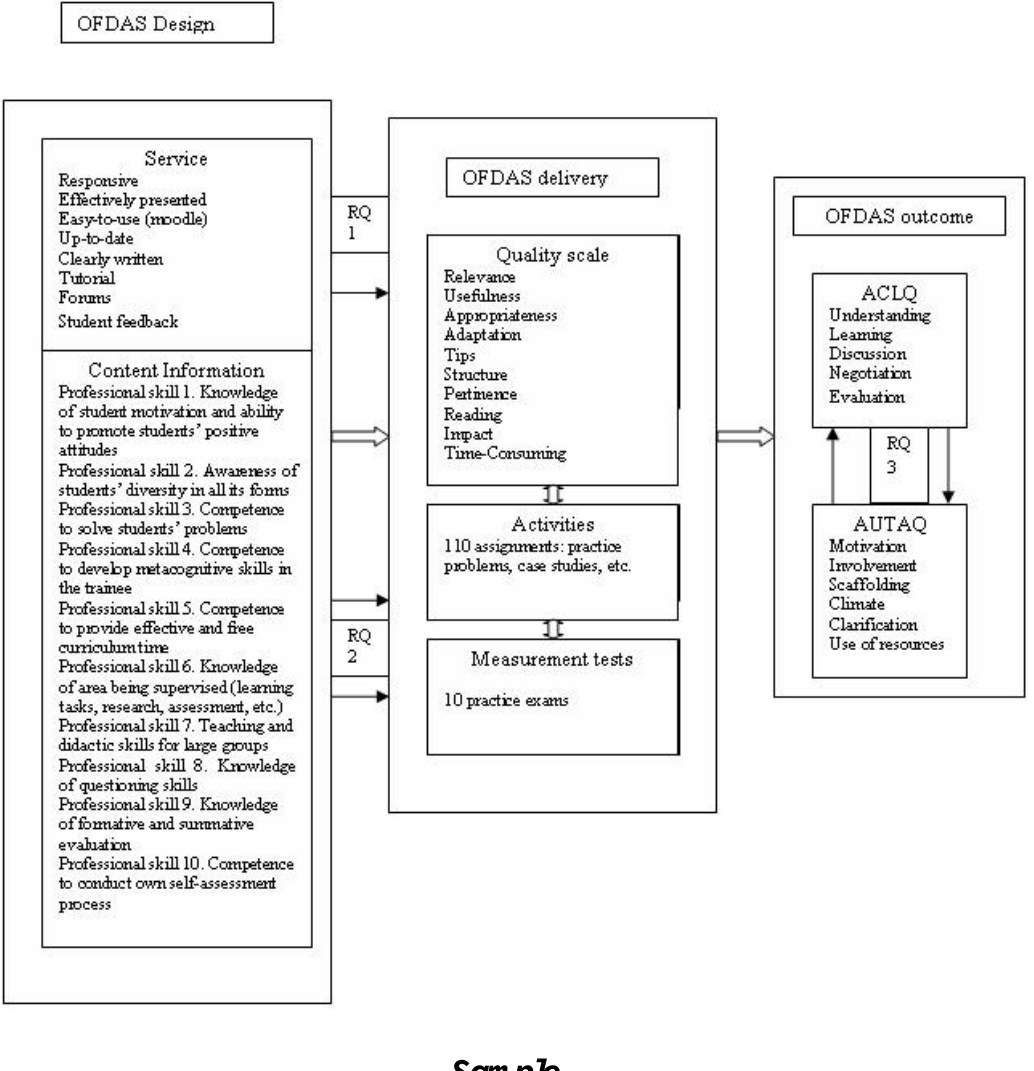
Figure 1. The OFDAS model and sample